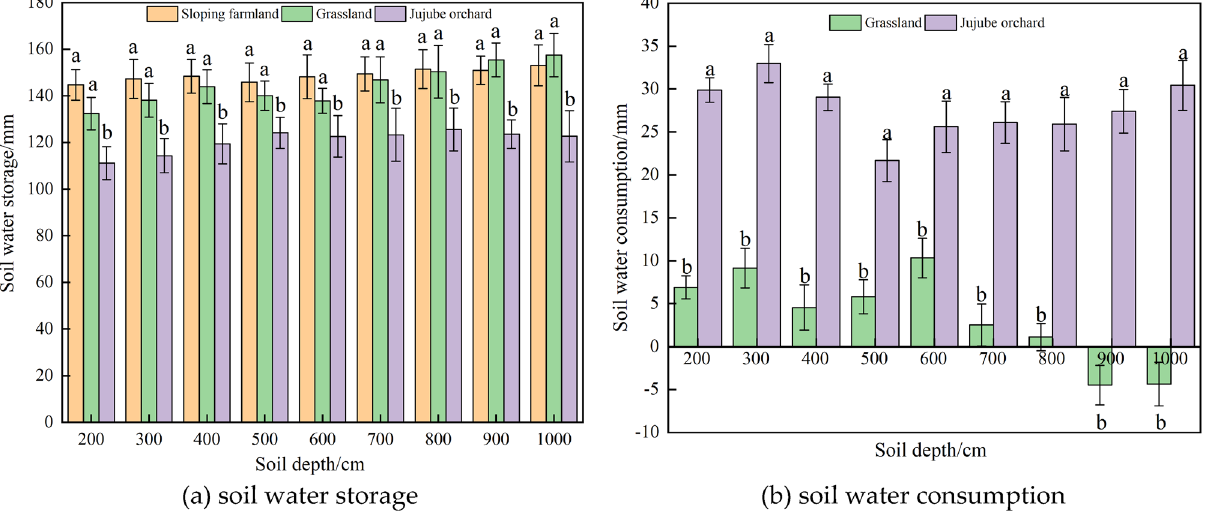
Figure 3. Vertical distribution of the deep soil water storage ( a ) and soil water consumption ( b ).